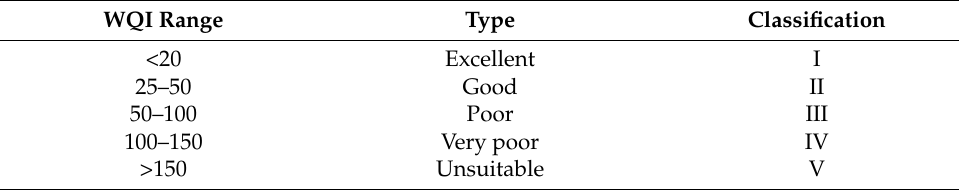
Table 5. Classification of Water quality index (WQI).